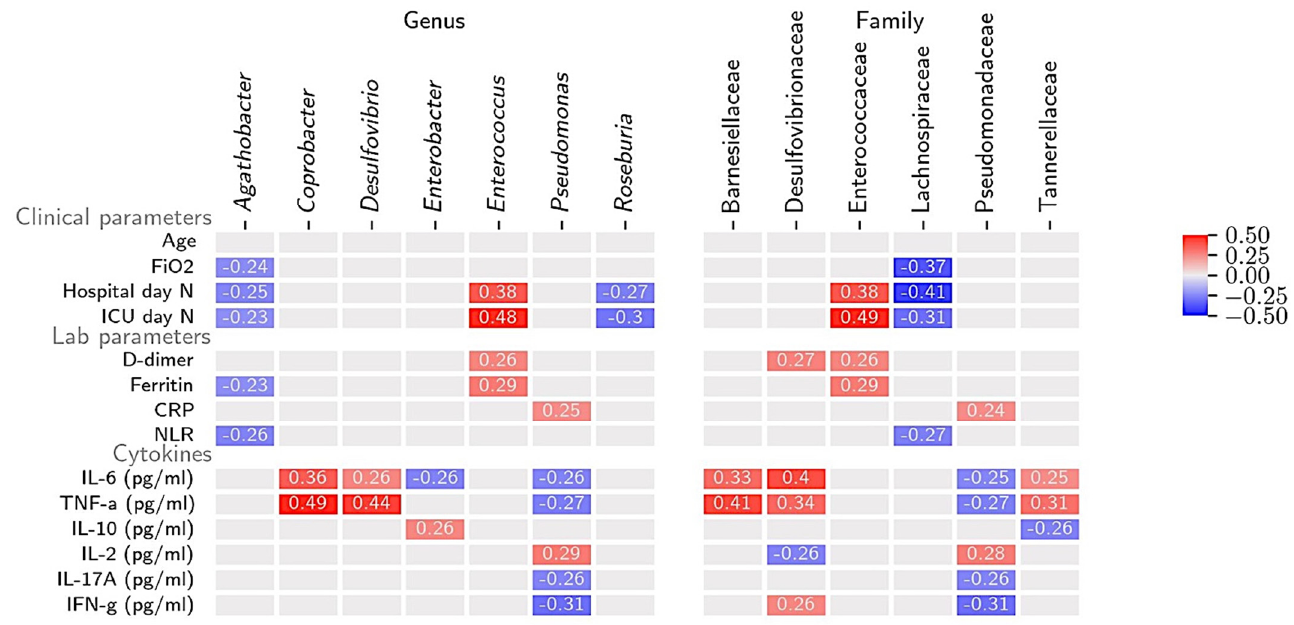
Figure 1. Correlation of gut microbiome composition with clinical and laboratory data at genus and family levels. (1) Clinical parameters. Data associated with COVID-19 progression included age, FiO2, days of hospitalization, and length of ICU stay. A strong positive correlation (>0.35) was observed between Enterococcus and duration of hospitalization and ICU days. Agathobacter and Roseburia and, at family level, Lachnospiraceae showed negative correlations with hospitalization and ICU stay. (2) Laboratory parameters and cytokines. Laboratory data characteristic of COVID-19 progression such as D-dimer and ferritin showed positive correlations with Enterococcus . Positive correlation was shown between inflammatory cytokines such as IL-6, TNF alpha with Coprobacter , Desulfovibrio and between IL-2 and Pseudomonas . Bacteria that were detected at least in 20 patients were shown. Only statistically significant ( p < 0.05) correlations are reported and abundance ≥ 0.1% is shown. The strength of the Rho coefficient is represented by the change in the square colour intensity. Lab = laboratory; FiO 2 = Fraction of inspired oxygen; ICU = intensive care unit; NLR = neutrophil to lymphocyte ratio; CRP = C-reactive protein. Unit of measurements: D-dimer ng/mL; ferritin ng/mL; CRP mg/dl; IL-6, TNF-alpha (TNF-a), IL-10, IL-2, IL-17A, INF-gamma (IFN-g): ng/mL.